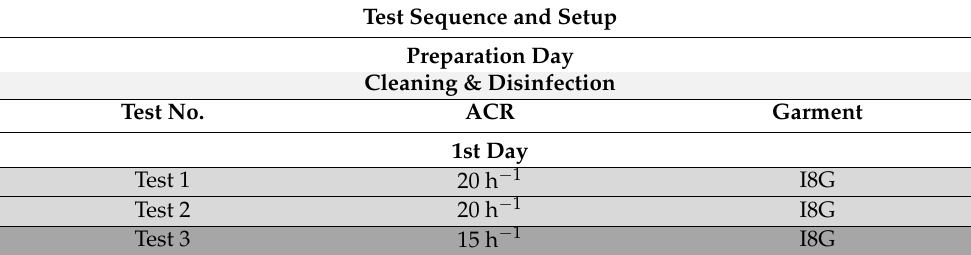
Table 1. Test Sequence and